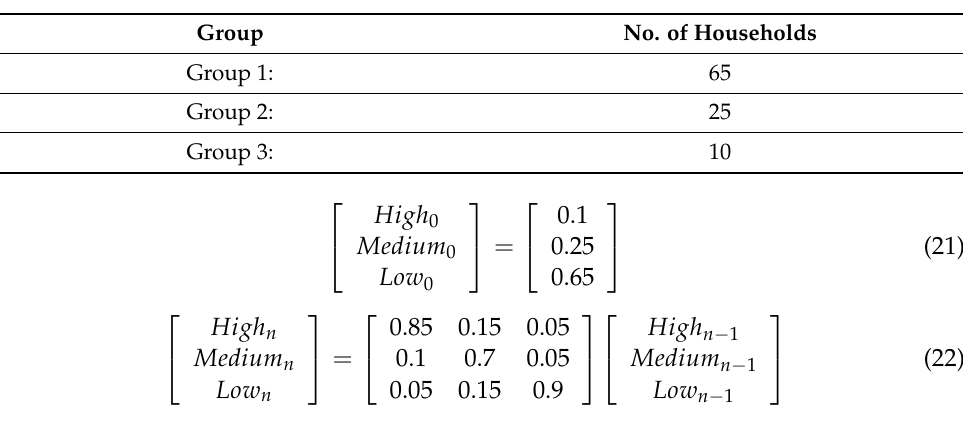
Table 3. Household distribution in the unelectrified